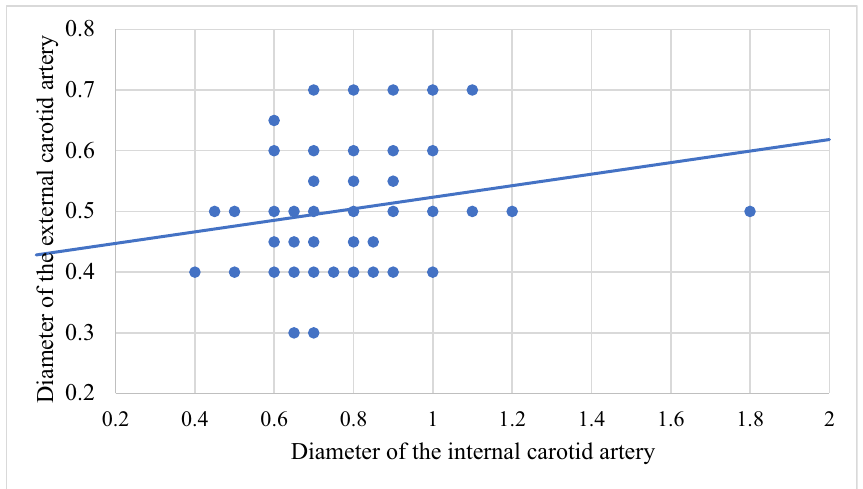
Figure 6. Correlation between the diameters of the internal carotid artery and the external carotid artery.